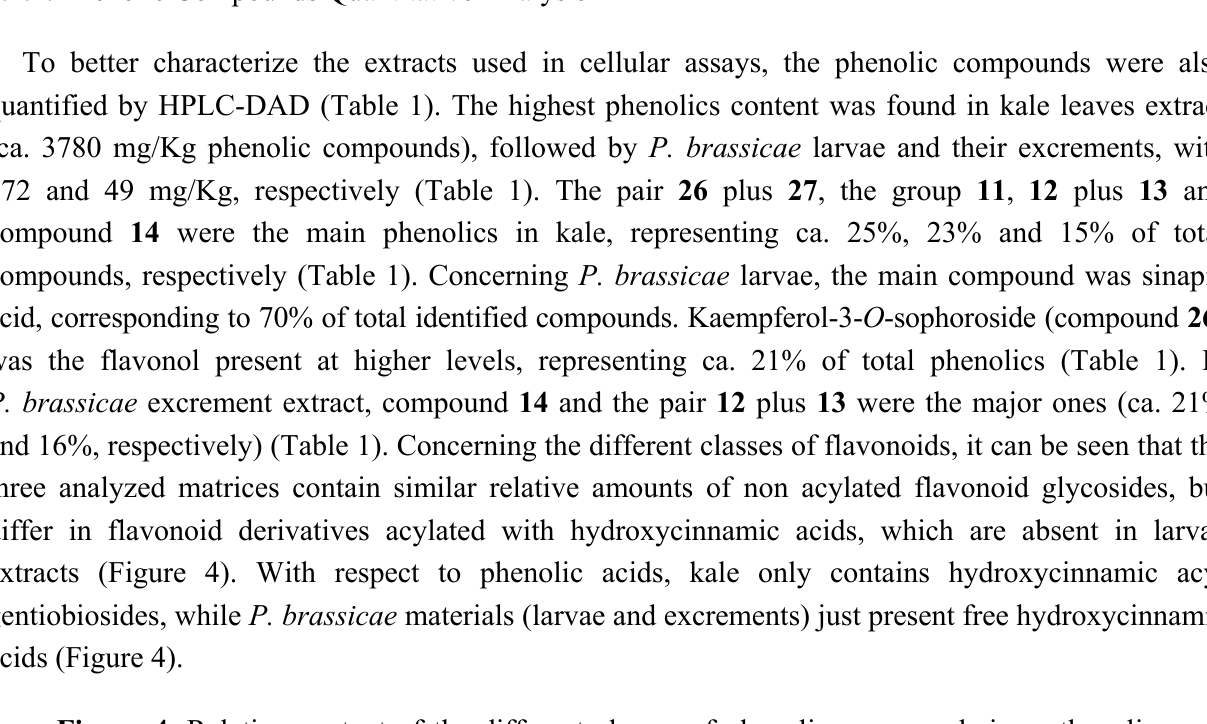
Figure 4. Relative content of the different classes of phenolic compounds in methanolic extracts of B. oleracea var. acephala and P. brassicae